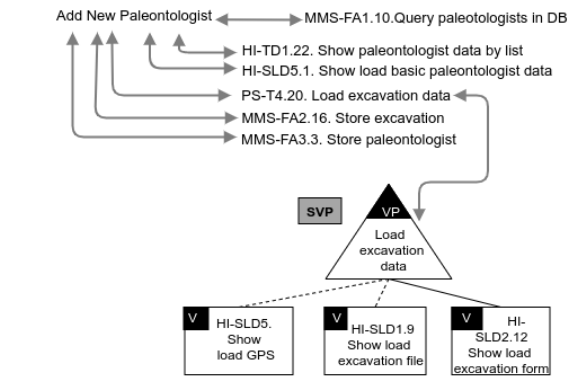
Figure 5. SeVaTax Model for Add New Paleontologist